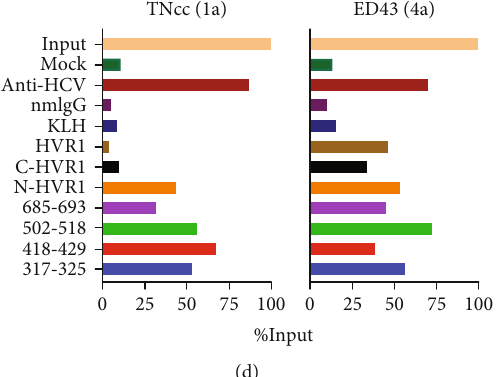
Figure 2: Humoral response induced by peptides. (a) Illustration of the immunization procedure. The peptide plus KLH protein, or PBS plus KLH protein, together with CFA or IFA, was inoculated into BALB/c mice at the indicated time points. (b) Kinetics of peptide-speci fi c antibody titers of the antisera. The endpoint titers of antisera collected at weeks 0, 3, 6, and 9 were determined by ELISA. Sera from mice without immunization, de fi ned as “ normal mouse serum, ” served as a baseline. The mean ± standard error of the mean ð SEM Þ of each group is shown. (c) The antiserum of each mouse was diluted at 1 :50, mixed with 100 FFU of HCVcc, and then added to naïve Huh7.5 cells. HCVcc without sera was added as a “ mock ” control. Seventy-two hours postinfection, the FFU was determined by an indirect immuno fl uorescence assay. The infection of “ mock ” was arbitrarily set to 100%, and the relative infection rates were calculated using GraphPad Prism 8 software. Each experiment was repeated in triplicate, and the representative data of 1 experiment is shown. The geometric mean of each group is displayed. (d) HCVcc TNcc(1a) or ED43(4a) stock ( ~ 106IU as “ input ” ) was precipitated with 2 μ g/mL IgG-coated Protein G Beads. Normal mouse IgG (nmIgG) and IgG puri fi ed from a convalescent hepatitis C patient (anti-HCV) were used as the negative and positive controls, respectively. HCVcc nonspeci fi cally binding to Protein G Beads without an IgG coating was de fi ned as a “ mock. ” HCV RNA of virus precipitated with beads was determined by qRT-PCR. Table 1: NT of mouse antisera against HCVcc of genotypes 1-6 and Dengue virus. 50